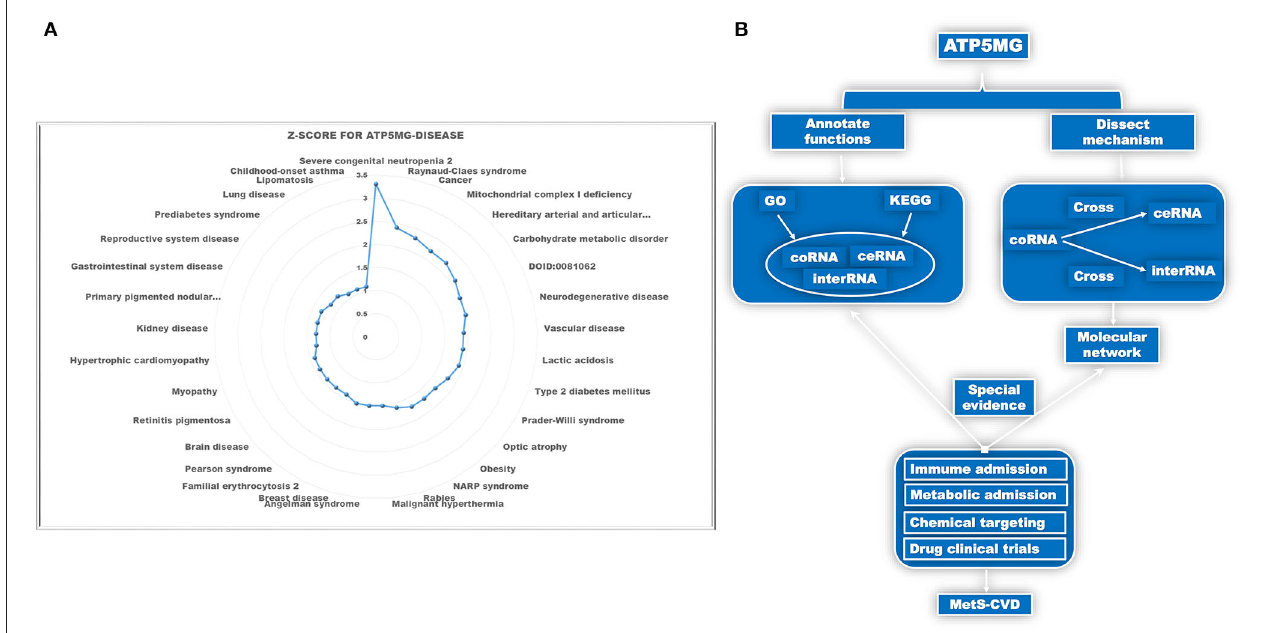
FIGURE 1 | Schematic diagram of the project design. (A) Dissect ATP5MG–disease associations by Z-score. (B) Design analysis scheme for biological functions and the underlying mechanisms of ATP5MG in